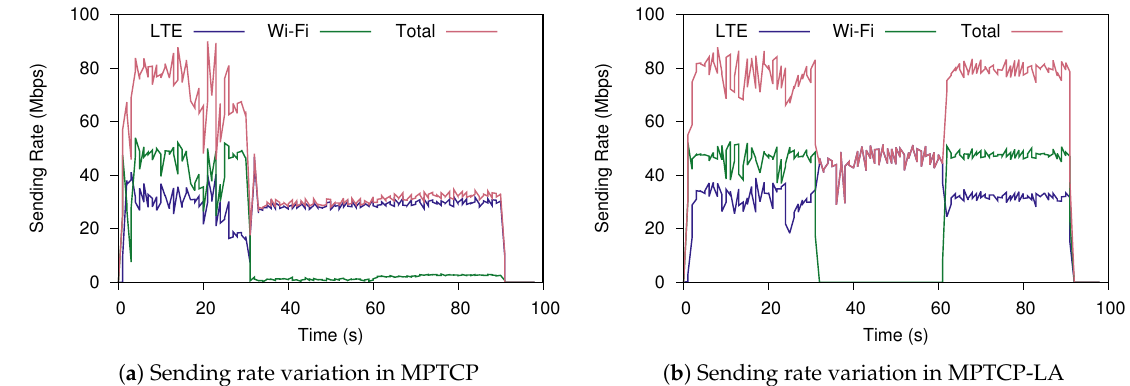
Figure 6. Comparing path use between MPTCP and